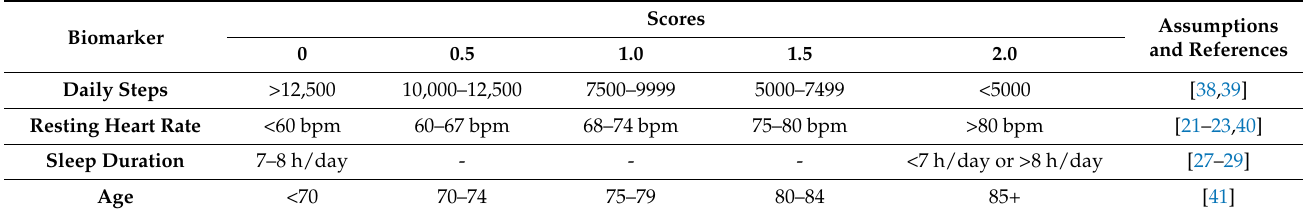
Table legend: bpm—beats per